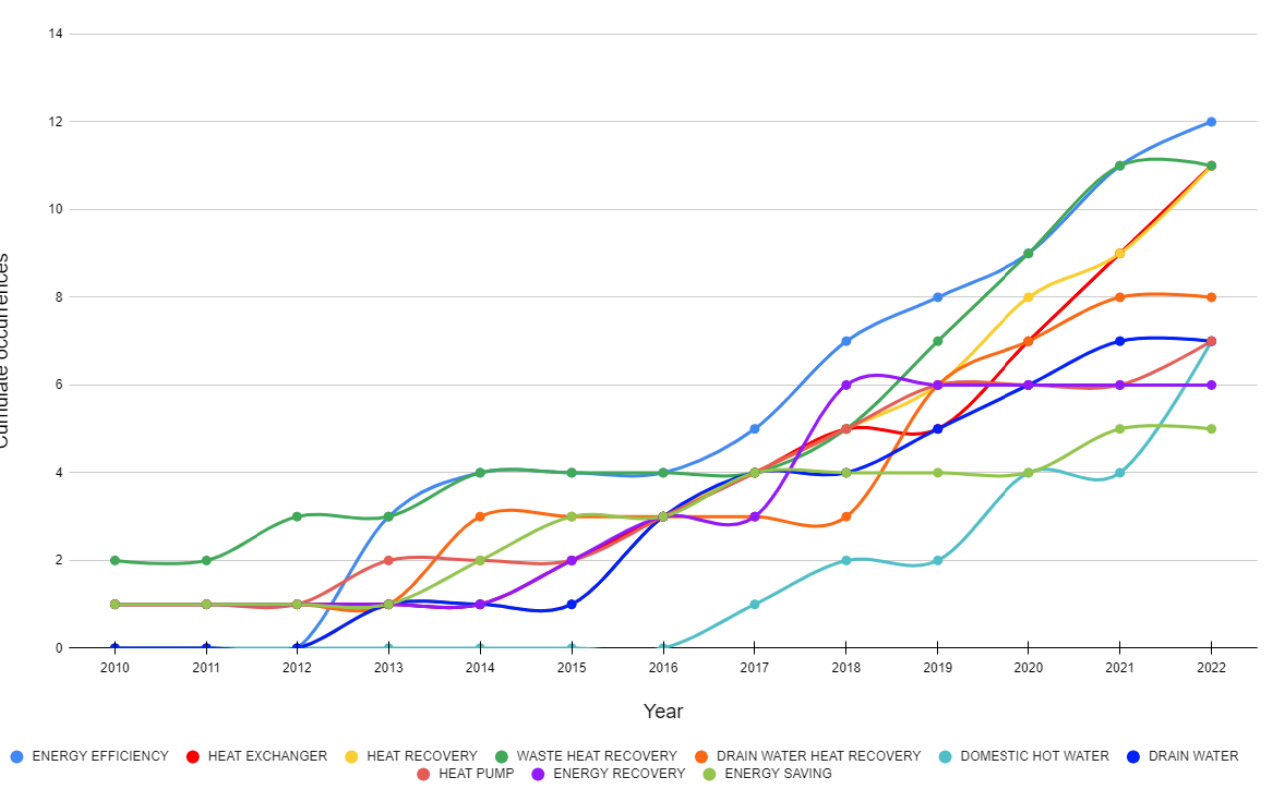
Figure 4. Author Keywords analysis for greywater energy recovery domain.